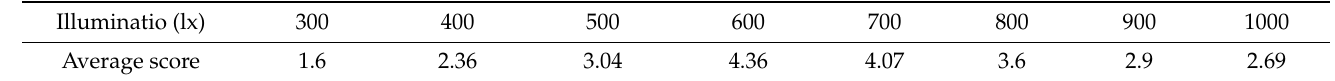
Table 9. Average value of the visual comfort score.